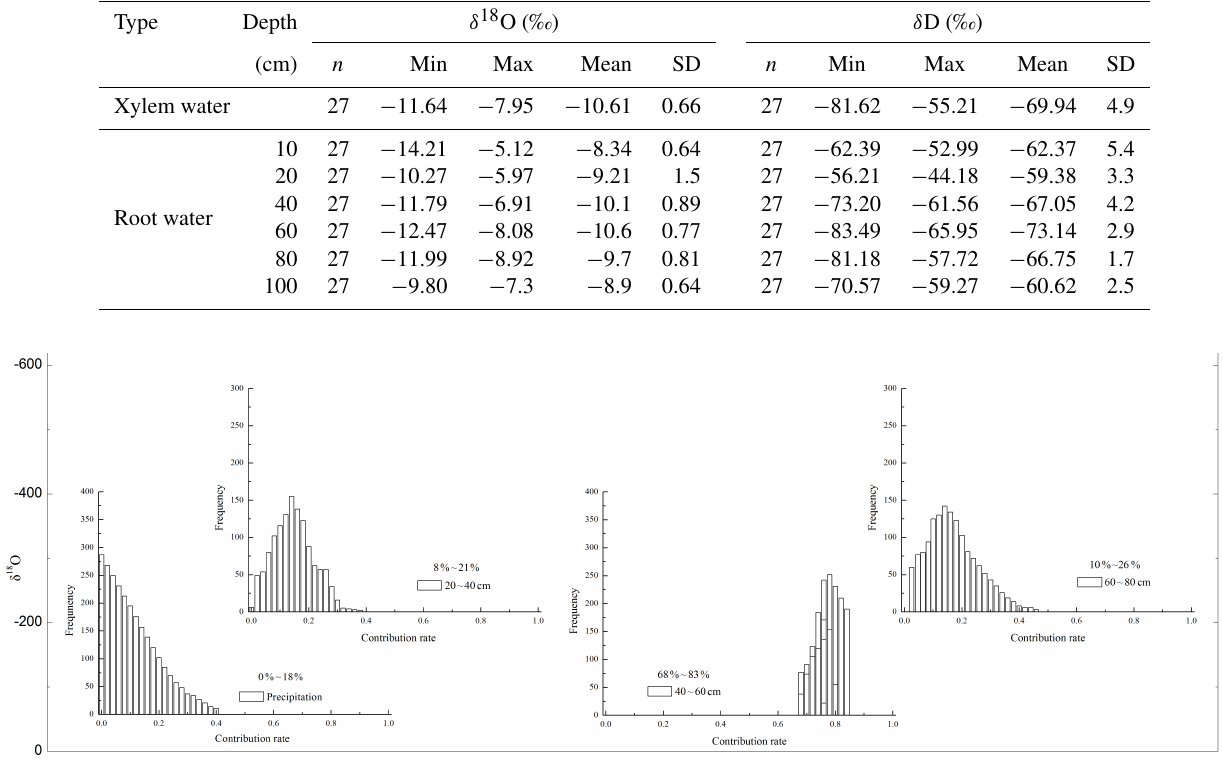
Table 2. Statistic characteristics of isotopic compositions for root water and xylem water in the study area. Type